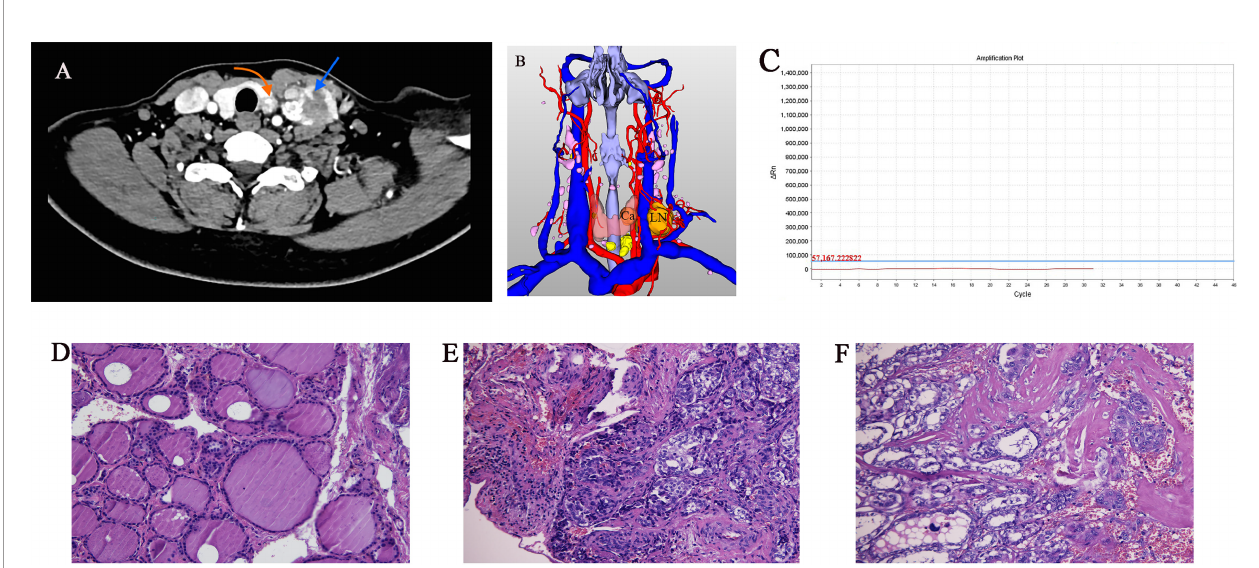
FIGURE 1 | Imaging and histology of matched PTC cases (Ca, primary PTC samples; LN, lymph node metastasis sample). (A) Axial CT contrast-enhanced scan of neck showing primary and lymph node metastasis tumors (arrows). (B) Three-dimensional CT imaging of neck. (C) BRAF gene mutation test result was negative. (D – F) Pathology sections of tumor tissue stained with hematoxylin and eosin showing typical paracancerous tissue, primary PTC, and lymph node metastasis (original magni fi cation